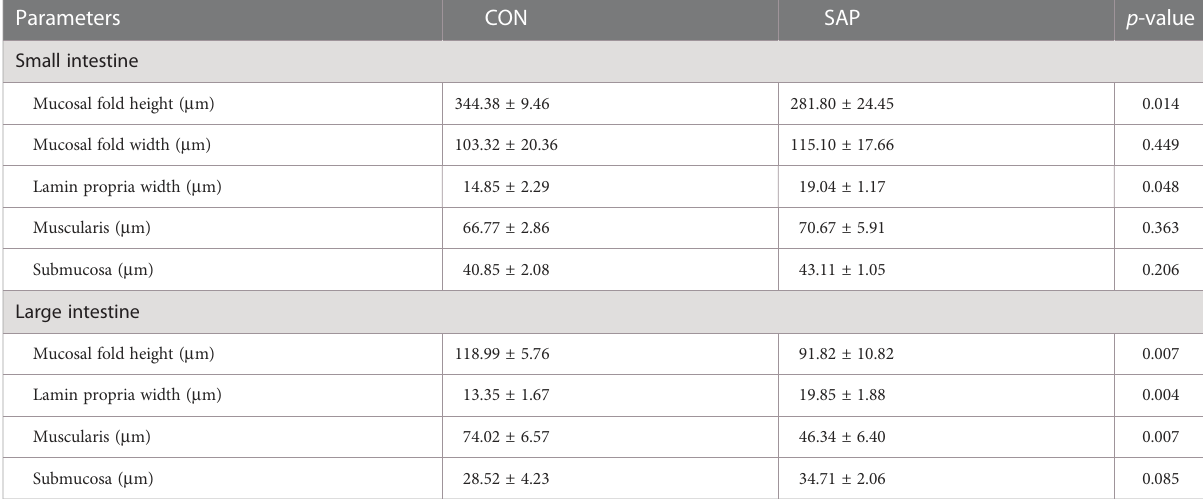
TABLE 3 Effect of dietary soybean saponin Bb on the intestinal microstructure of juvenile P. sinensis ( n = 3). Parameters